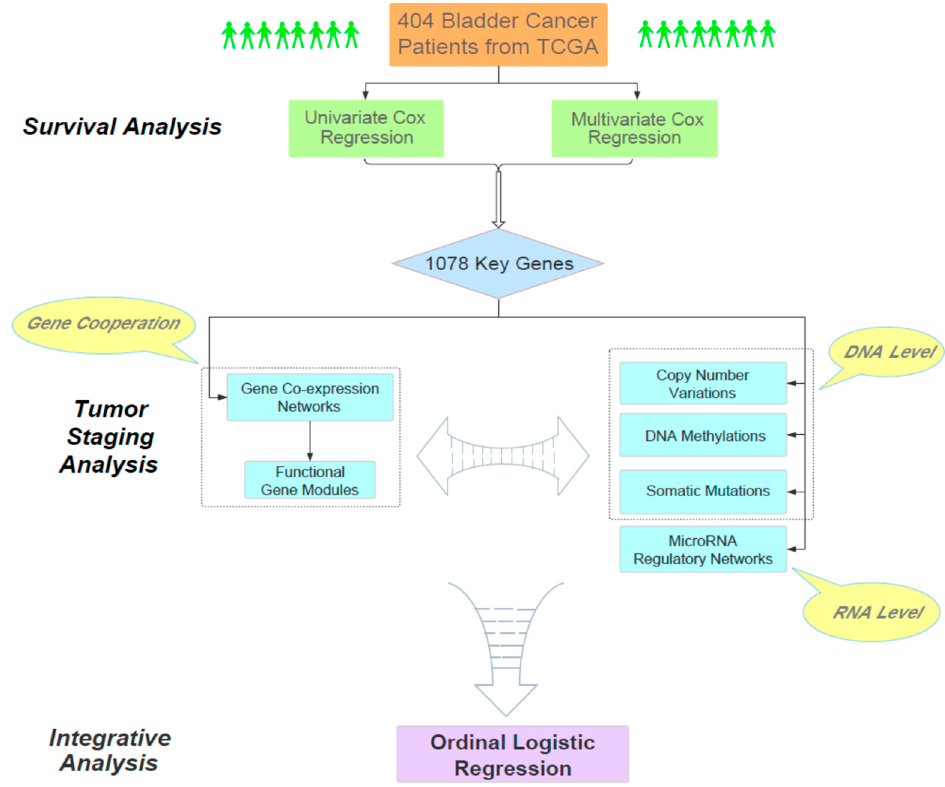
Figure 1. The flowchart of our analysis pipeline.